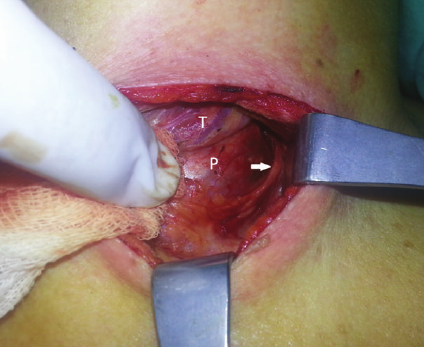
Figure 3: Left lobectomy and parathyroid adenomectomy. T: thy- roid; P: parathyroid; arrow indicates the arterial shift caused by cyst.